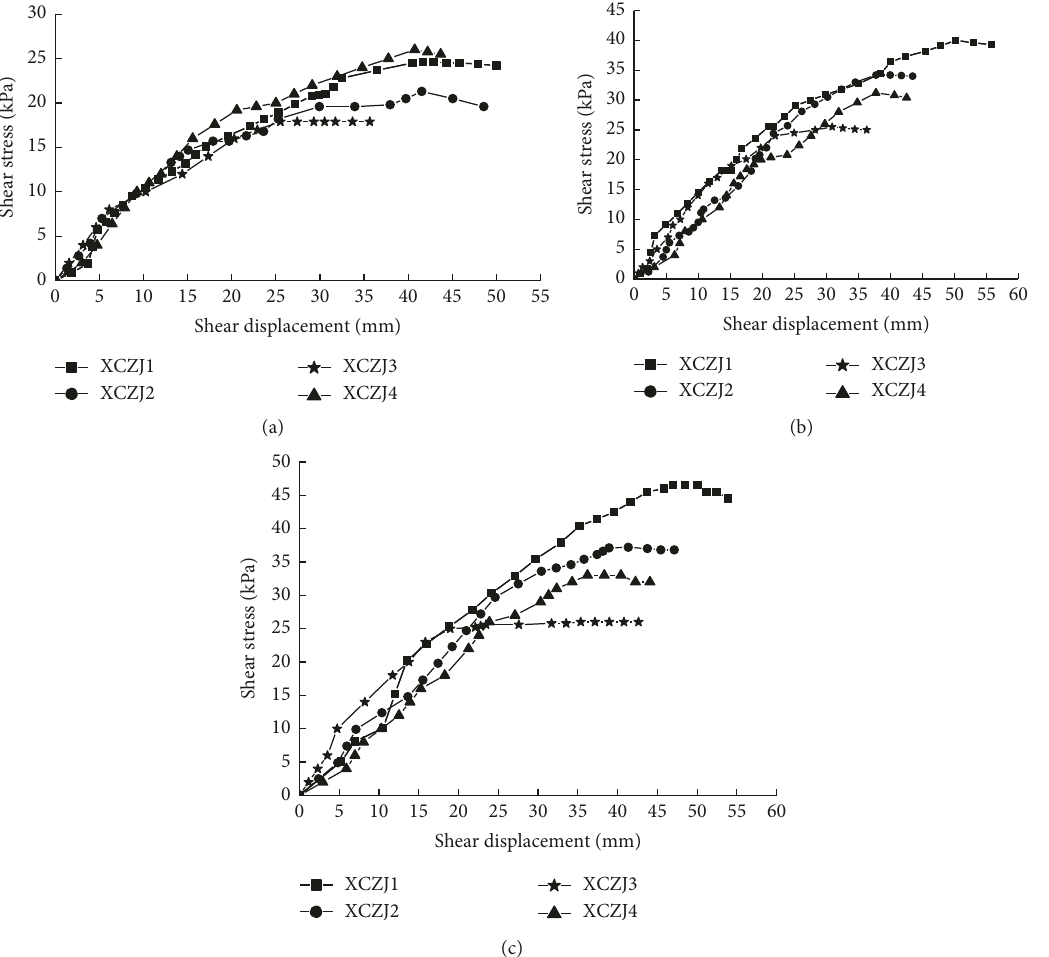
Figure 6: Shear stress and shear displacement curves of in situ direct shear tests: (a) 20.00kPa; (b) 33.33kPa; (c)